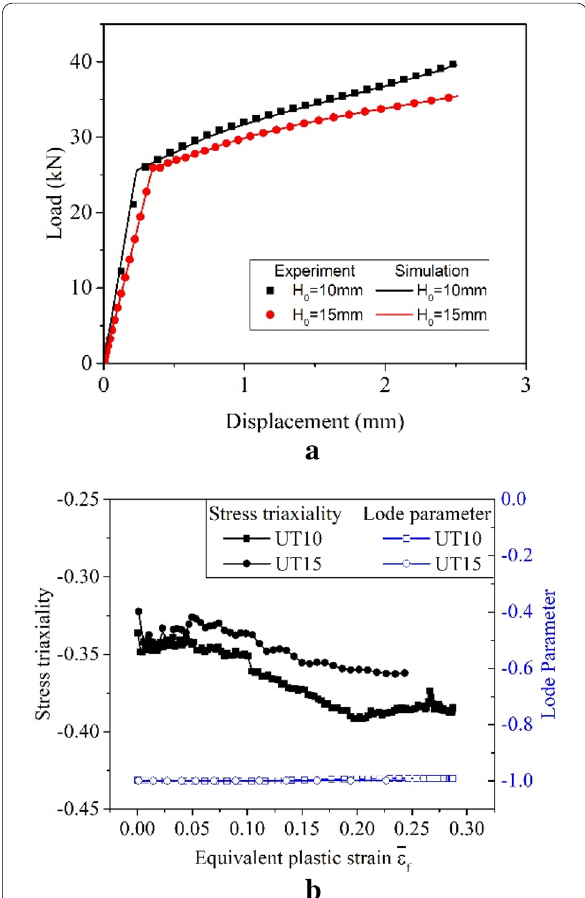
Figure 12 Compression test: a force–displacement responses from experiments and simulations and ( b ) the evolution of ST and LP with plastic